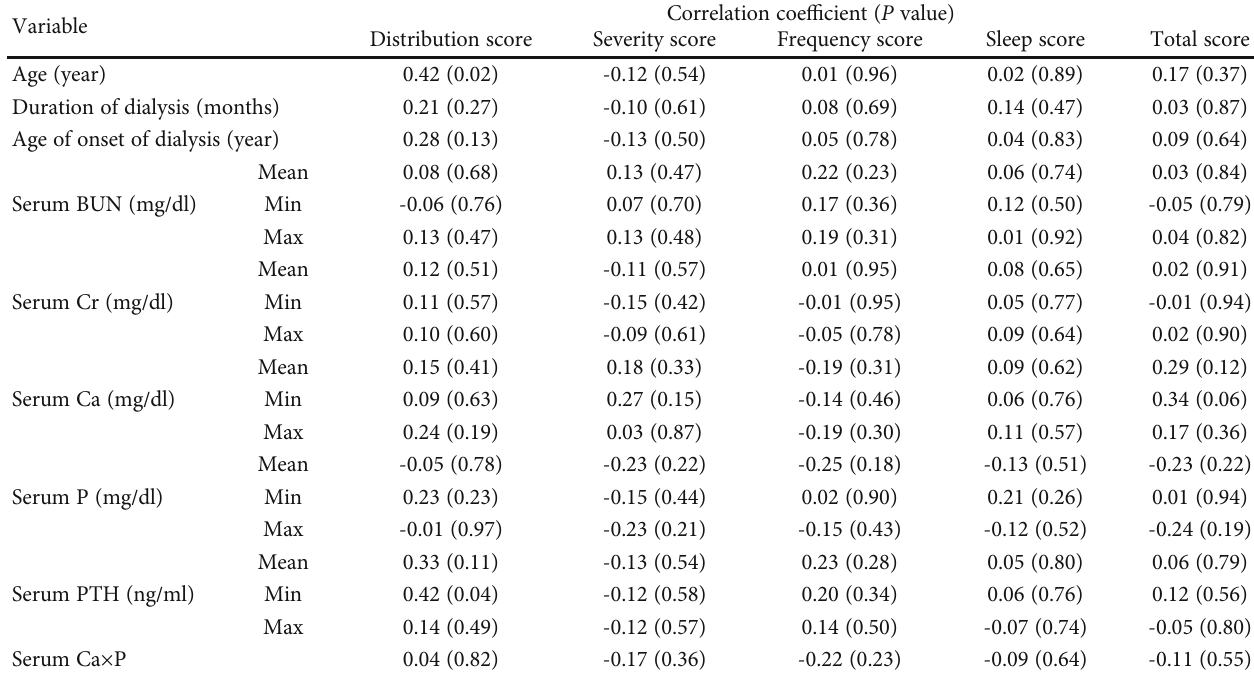
Table 5: Correlation between quantitative variables and pruritus score in terms of Spearman ’ s rho.